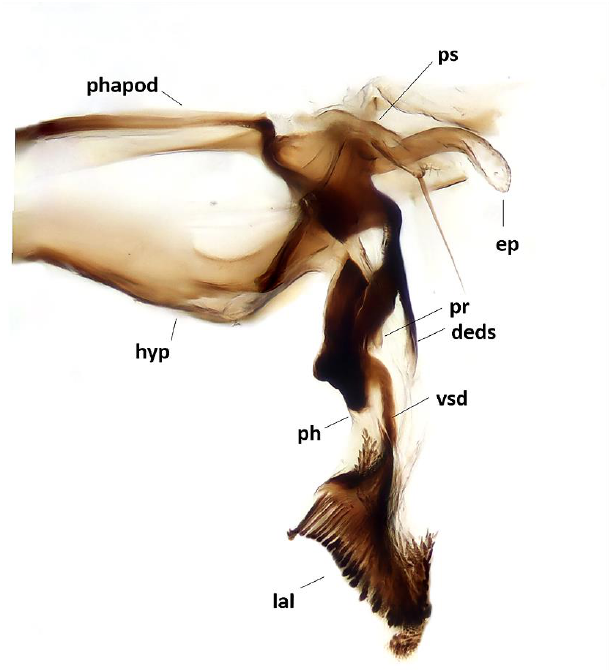
Figure 5. Baniassa pennata sp. nov., male terminalia (holotype ♂ , BLKU): hypandrial complex in lateral view, phapod = phallapodeme, deds = dorsal extension of dorsal sclerite of distiphallus, ep = epiphallus, hyp = hypandrium, lal = lateral lobes, ph = phallus, pr = tip of pregonite, ps = postgonite, vsd = ventral sclerotization of